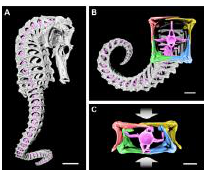
Figure 1. The skeleton of a seahorse (Source: Justin Holt, Design and Testing of a Biomimetic Pneumatic Actuated Seahorse Tail Inspired Robot